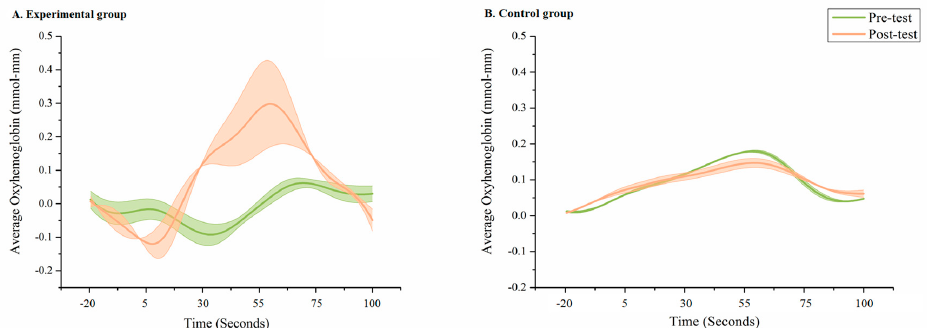
Figure 4. The courses over time of the mean oxy-Hb signals in the left lateral frontal lobe that were measured during the 20 s pre-task baseline period and the 105 s 1-back tasks. The fNIRS signals of four task blocks were averaged at the same sampling point along 125 s (totally 6250 sampling points) to obtain the time series figure for improving the signal-to-noise ratio (SNR).